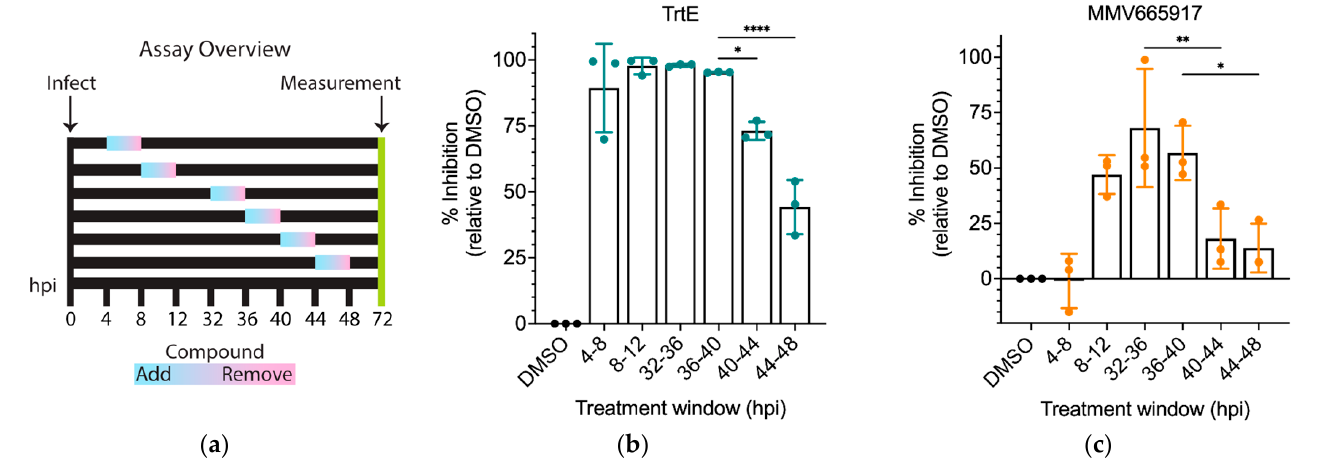
Figure 5. TrtE is most effective during the asexual stage of Cryptosporidium . ( a ) Overview of the modified infection assay to test stage specificity of the compound. Graphs show the percent inhibition of ( b ) trtE and ( c ) MMV665917 relative to DMSO. The data plotted are means ± S.D of three independent experiments. Statistical significance was determined using one-way ANOVA and